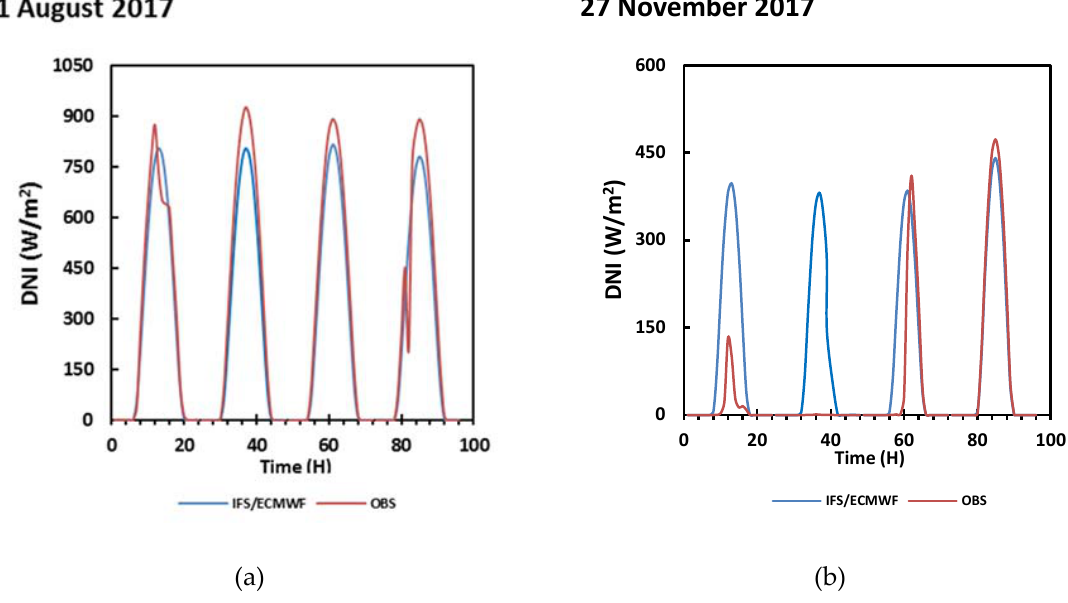
Figure 2. Example of four consecutive days of observed (red line) and forecasted (blue line) hourly mean DNI in Évora starting at ( a ) 1 August 2017 00:00 and ( b ) 27 November 2017 00:00.